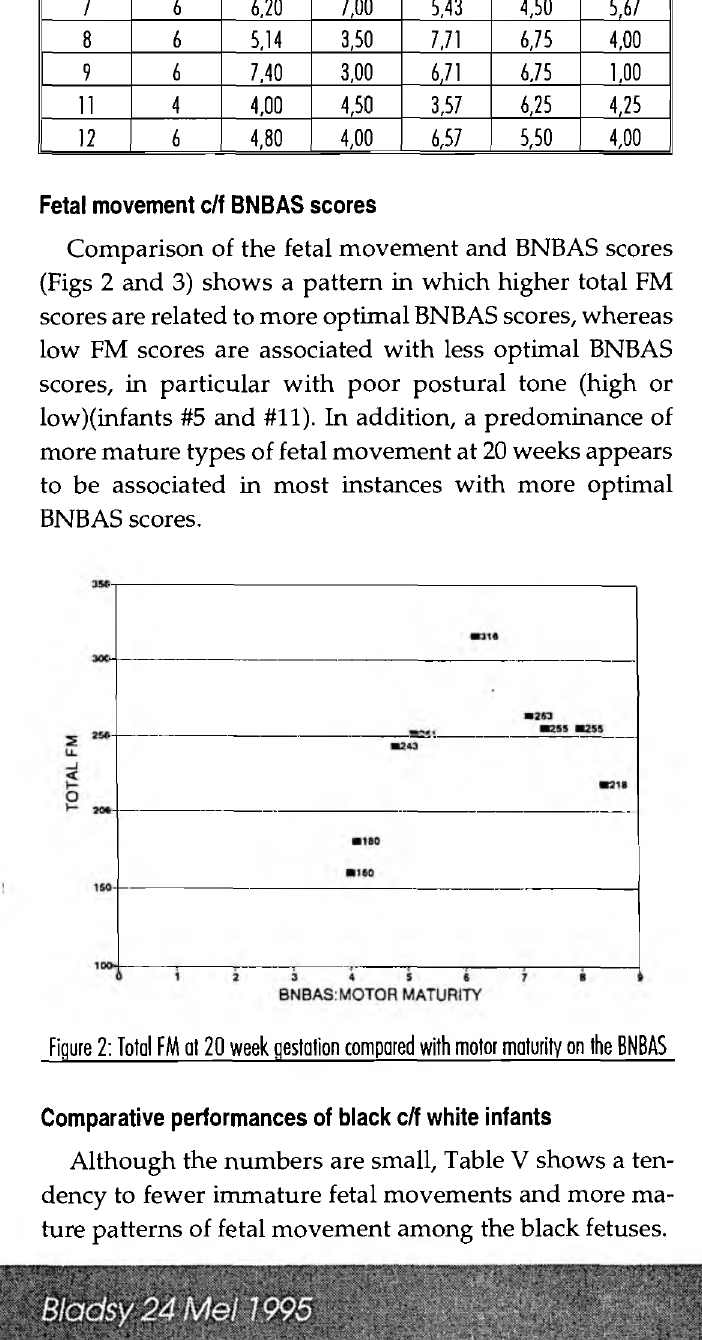
Figure 3: Totol FM at 20 week gestation compared with orientation/alertness on the BNBAS